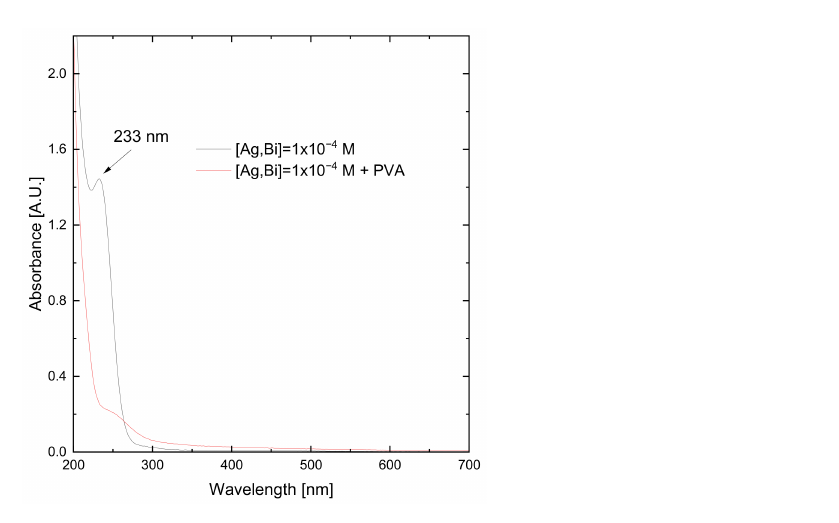
Figure 4. UV–Vis spectra of solutions of synthesized silver–bismuth nanoparticles in the presence and absence of a stabilizer (PVA), at both silver and bismuth concentrations of 1 × 10 − 4